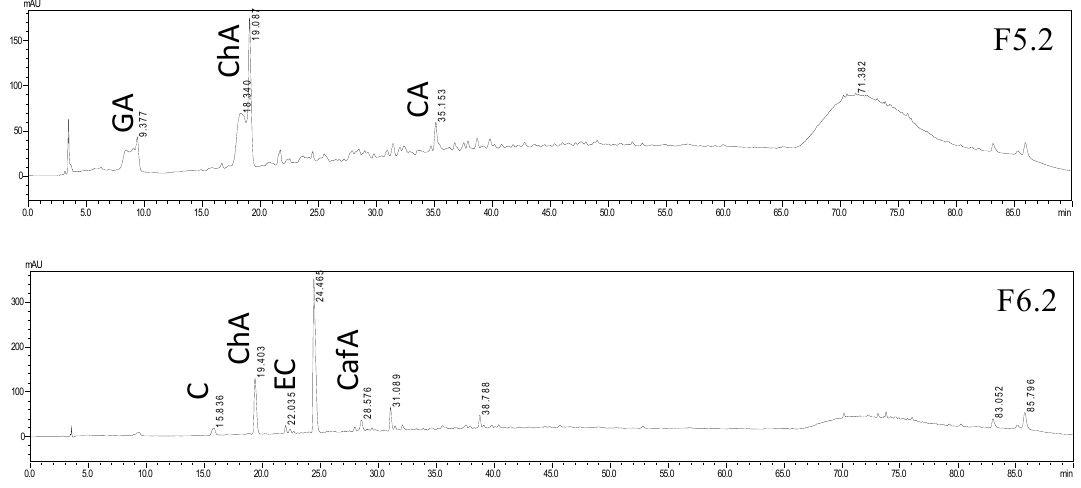
Figure 5. High performance liquid chromatography (HPLC) of sub-fraction of T. clathrus ethyl acetate extract at 254 nm. GA—gallic acid, ChA—chlorogenic acid, CA—coumaric acid, EC—epicatechin, C—catechin, CafA—caffeic acid.